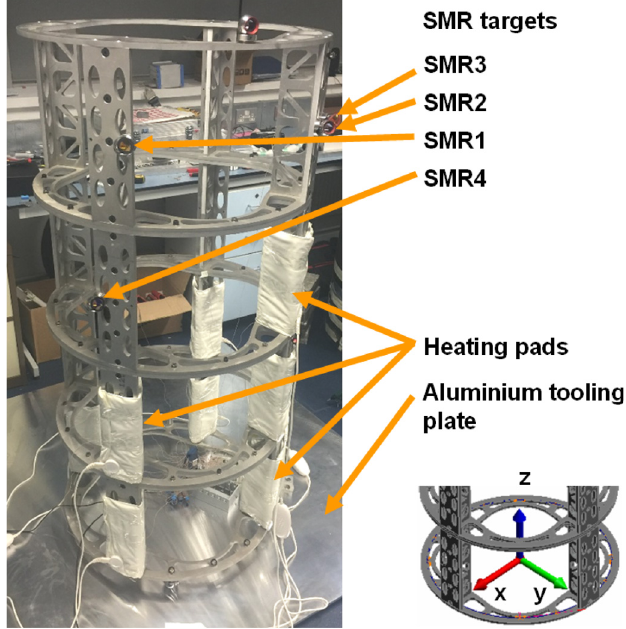
Fig. 4. Experimental